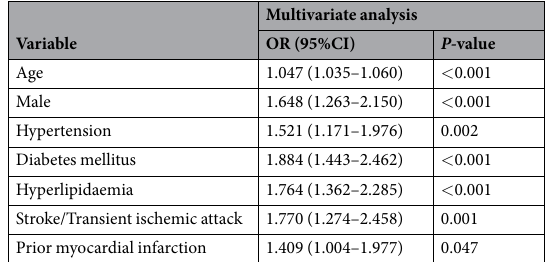
Table 2. Associations between baseline clinical characteristics and prevalence of acute myocardial infarction in patients with atrial fibrillation. OR, odds ratio; CI, confidence interval.